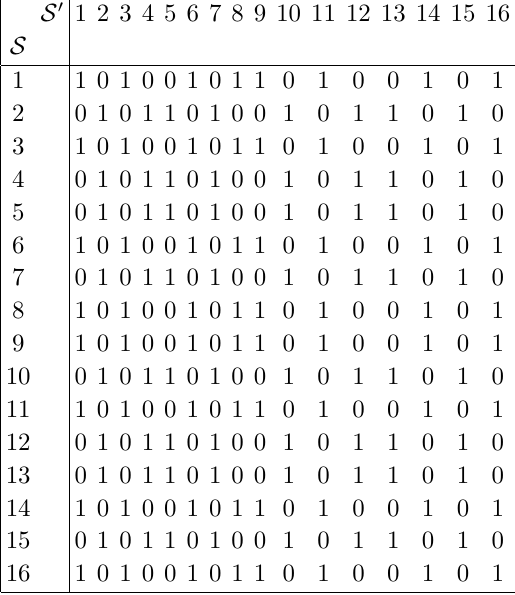
(cid:2) P with di(cid:11)erent boolean factors. [2] [2]